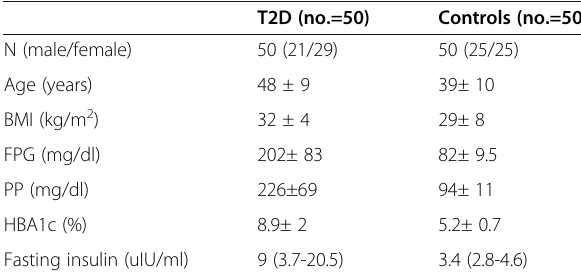
Table 1 Demographic, clinical, and laboratory data of the studied